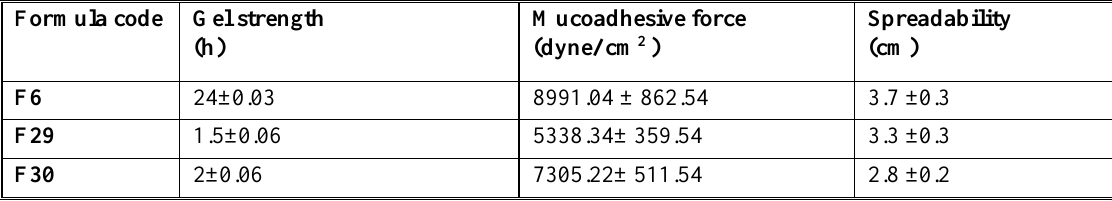
Table 6. Gel Strength, mucoadhesive force and spreadability of SC oral in-situ gel selected formulas (mean ±SD)